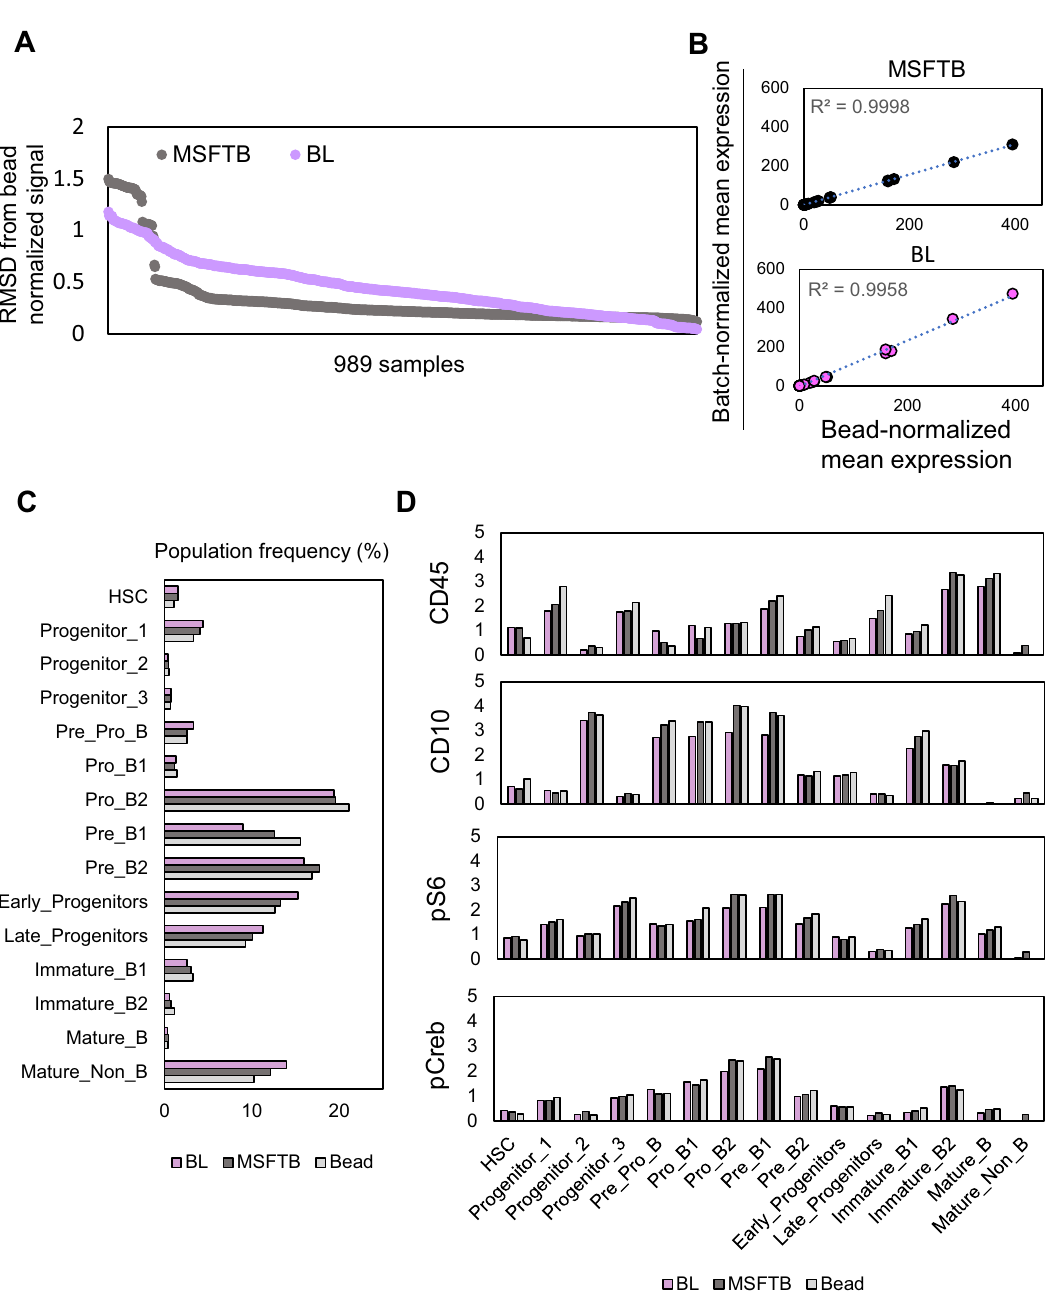
Fig. 4 Batch normalization recapitulates bead normalization performance. A Comparison of batch and bead normalized mean expression across 989 leukemia samples using MSFTB and BL normalizations. The differences between batch and bead normalized signals were quanti fi ed by the RMSD values. B Correlation analysis between batch and bead normalized expression of 36 consensus marker expressions from one selected patient sample. The R 2 values normalized using MSFTB and BL normalizations were 0.999, and 0.996, respectively. C Comparison of 15 ALL subpopulation frequencies in 50 selected leukemia patient samples normalized by MSFTB and BL normalization functions compared to bead standardization (see Supplementary Fig. 10 for the complete quanti fi cation of 15 subpopulation frequencies normalized by each normalization method). D Mean expression of four markers: CD45, CD10, pS6, and pCreb in 15 subpopulations of 50 selected leukemia patient samples normalized using MSFTB, BL, or bead normalization (see Supplementary Fig. 11 for the complete quanti fi cation on the mean expression of four markers by each of the fi ve normalization functions). Source data are provided as a Source Data fi